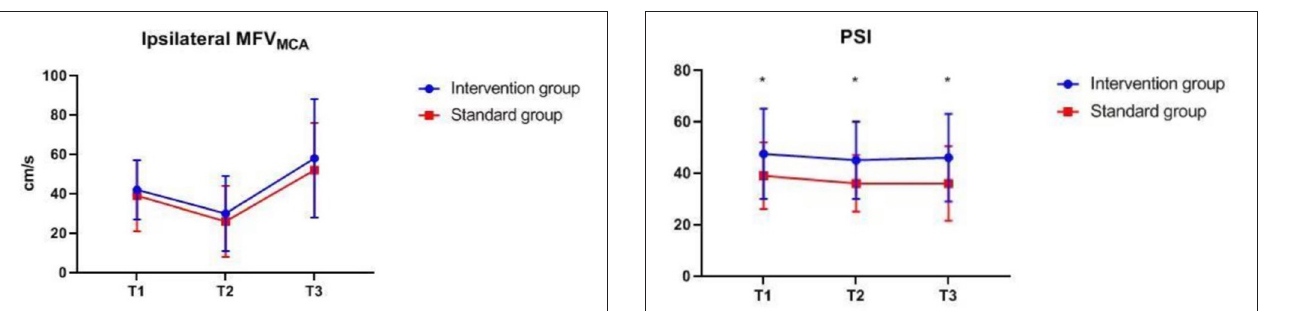
FIGURE 8 | PSI at corresponding time points. PSI, patient state index, * P < 0.05 from standard group (statistically significant). The measurement time interval after general anesthesia but before clamping the carotid artery was recorded as baseline reference T1, the time interval after clamping but before declamping was recorded as T2, and the time interval after the declamping and stabilization of cerebral perfusion but before completion of surgery was recorded as